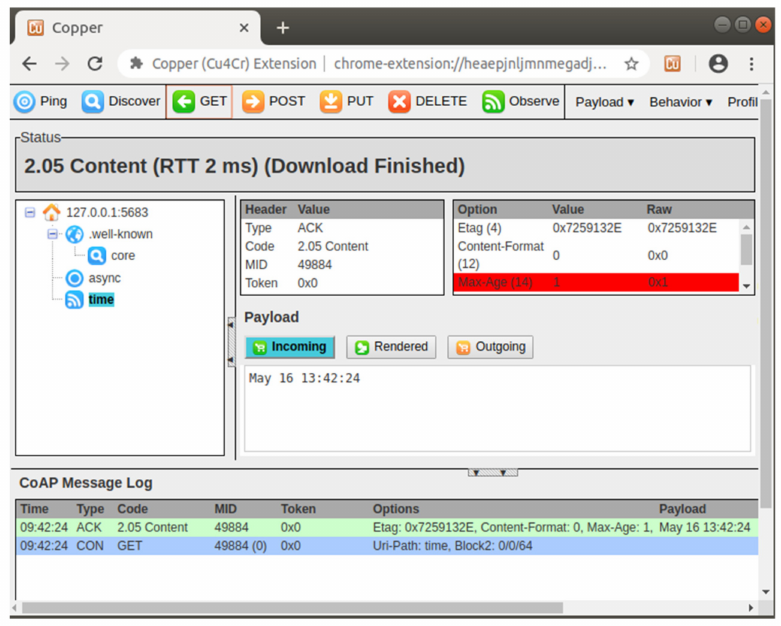
Figure 12. Initiation of Copper without DTLS